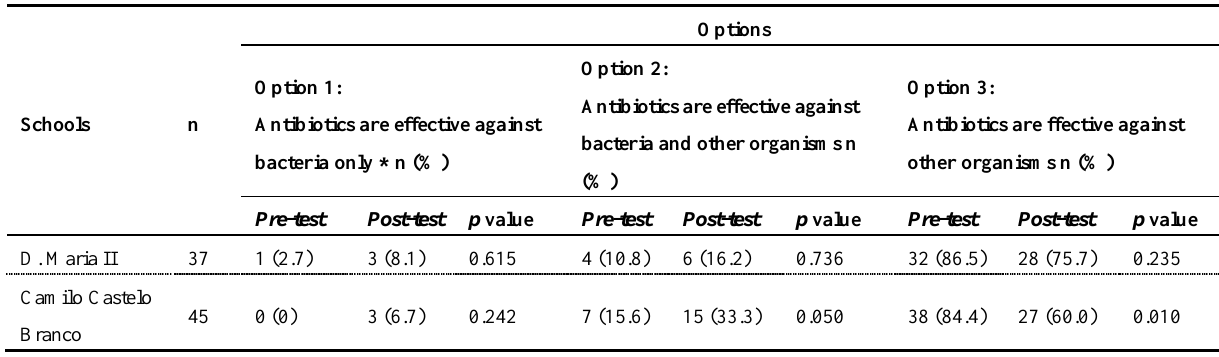
Table 1. Number of positive answers to the question on antibiotic use against bacteria and other